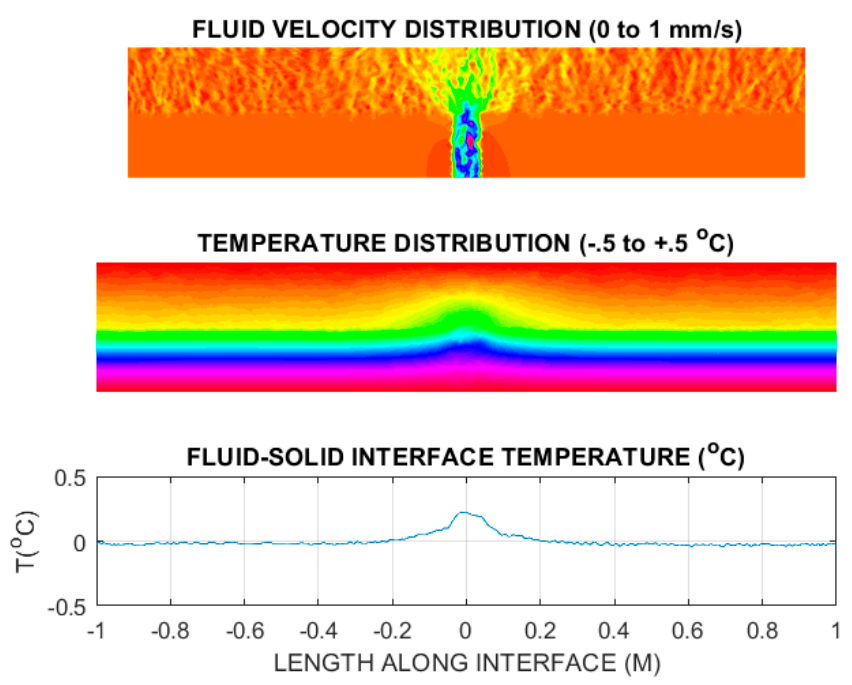
Figure 4. ( Upper ) Velocity field representing fluid flow and heat transport in Figure 2 fracture-connectivity structure entering a wellbore fluid; background flow from the crust into the fluid is seen along the interface. ( Middle ) 2D representation of Figure 2 temperature events as heat transport from a hotter low-permeability medium (red-magenta layers representing hotter crustal rock) to a colder high-permeability medium (yellow-oranges layer representing wellbore fluid). ( Lower ) Temperature profile measured along the fluid-crust interface representing Figure 2 wellbore axial temperature profiles.